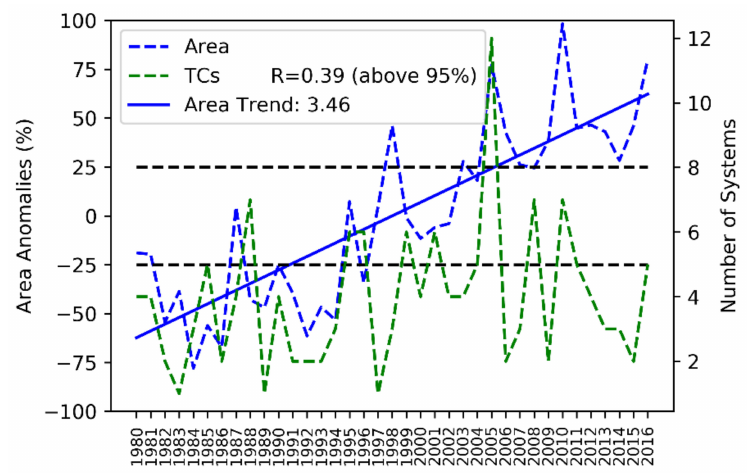
Figure 7. Temporal evolution of the AWP area anomalies (AWP–AA) (discontinuous blue line), its trend (blue line), and the total number of TCs that a ff ected Cuba (discontinuous green line). Dashed black lines show 25% of AWP–AA. The R value is the correlation coe ffi cient between both series. Period: